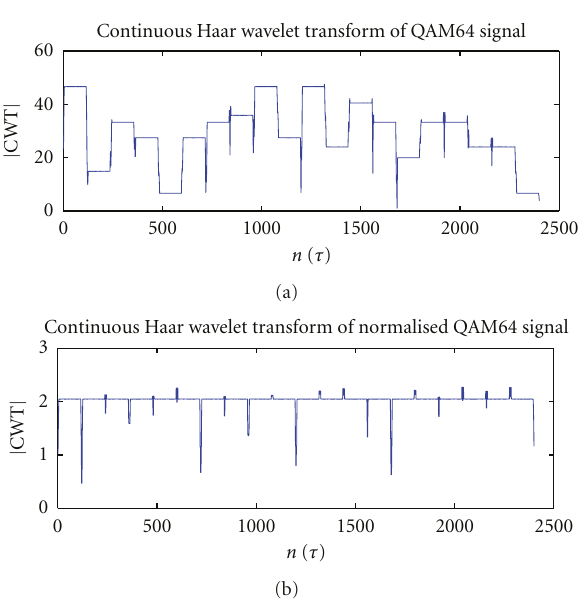
Figure 1: Multi-step wavelet transform of QAM64 signal and constant wavelet transform of its normalized version.